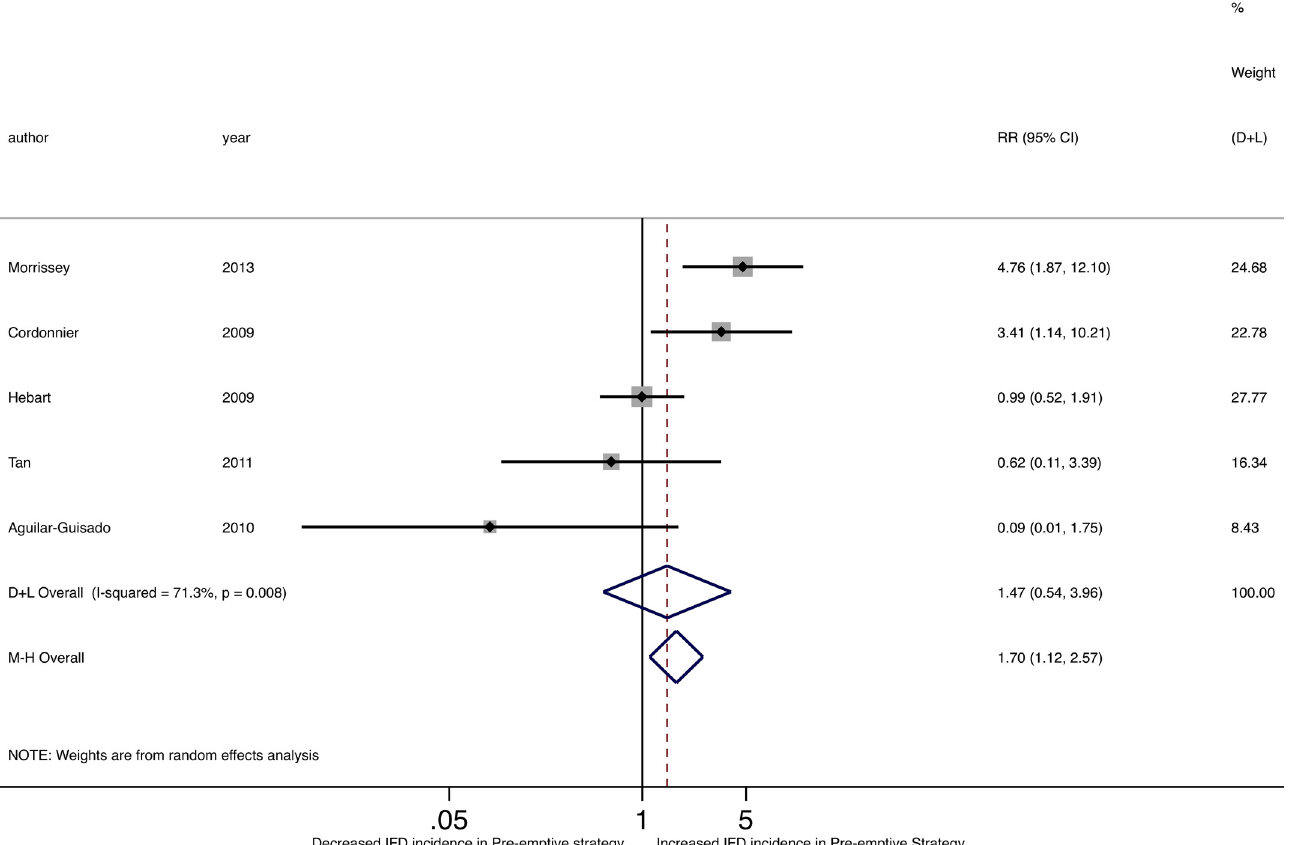
Fig 5. Forest plot of pooled relative risk of IFD detection comparing pre-emptive to empirical strategies.